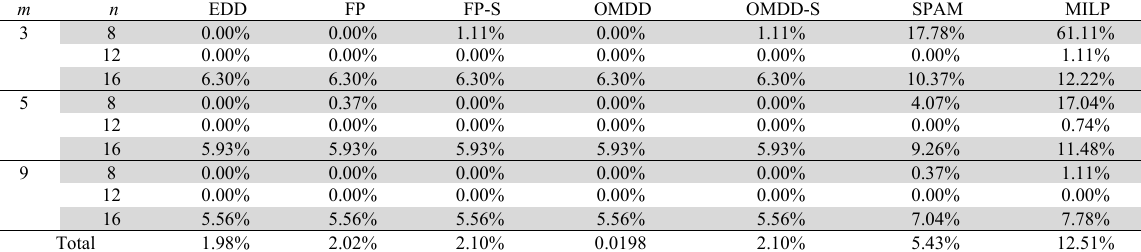
Small-sized test instances: optimality percentage for m and n